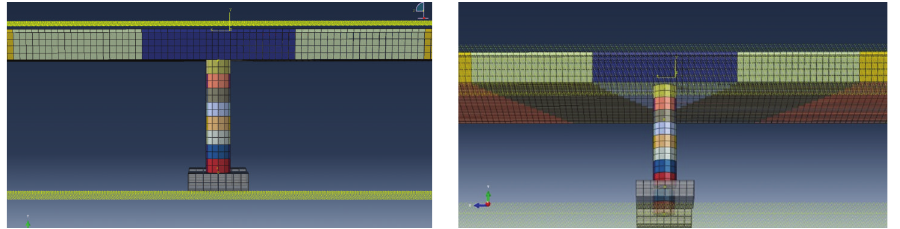
Figure 7: Separation of the loading surfaces of column and bridge deck to model the spherical propagation of the blast